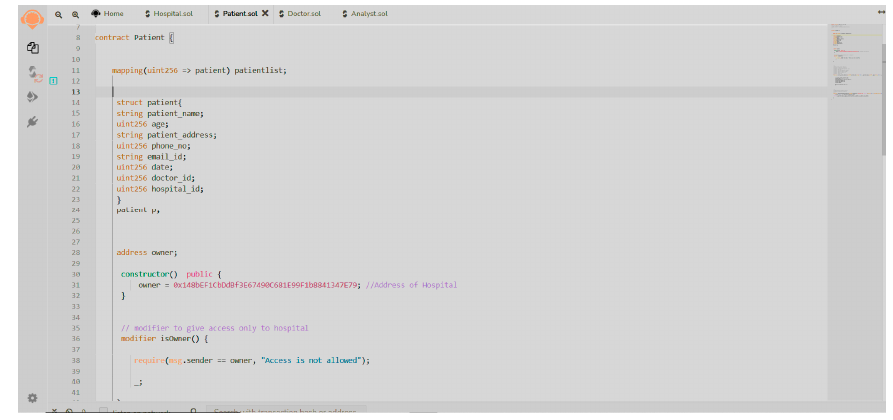
Figure 9. ( a ) Registration interface; ( b ) Team Health welcome interface.